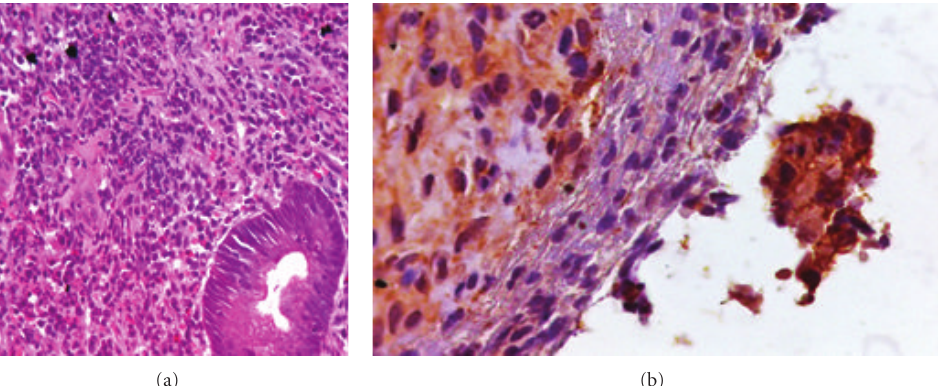
Figure 2: Histopathological study with dense inflammatory infiltration rich in plasmocytes and immunohistochemical test positive for Treponema pallidum